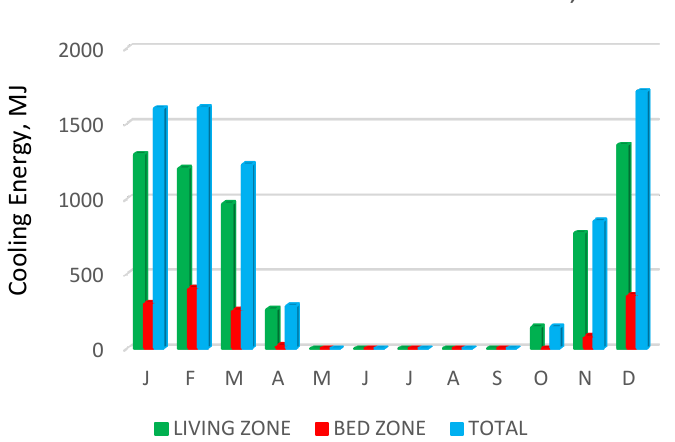
Figure 14. Monthly cooling energy for living room and bedrooms, and the total (economy-cycle mode). The values shown in Figures 14–16 are very much similar to those for normal cycle (Figures 9–11) indicating insignificant impact of the economy-cycle operation.